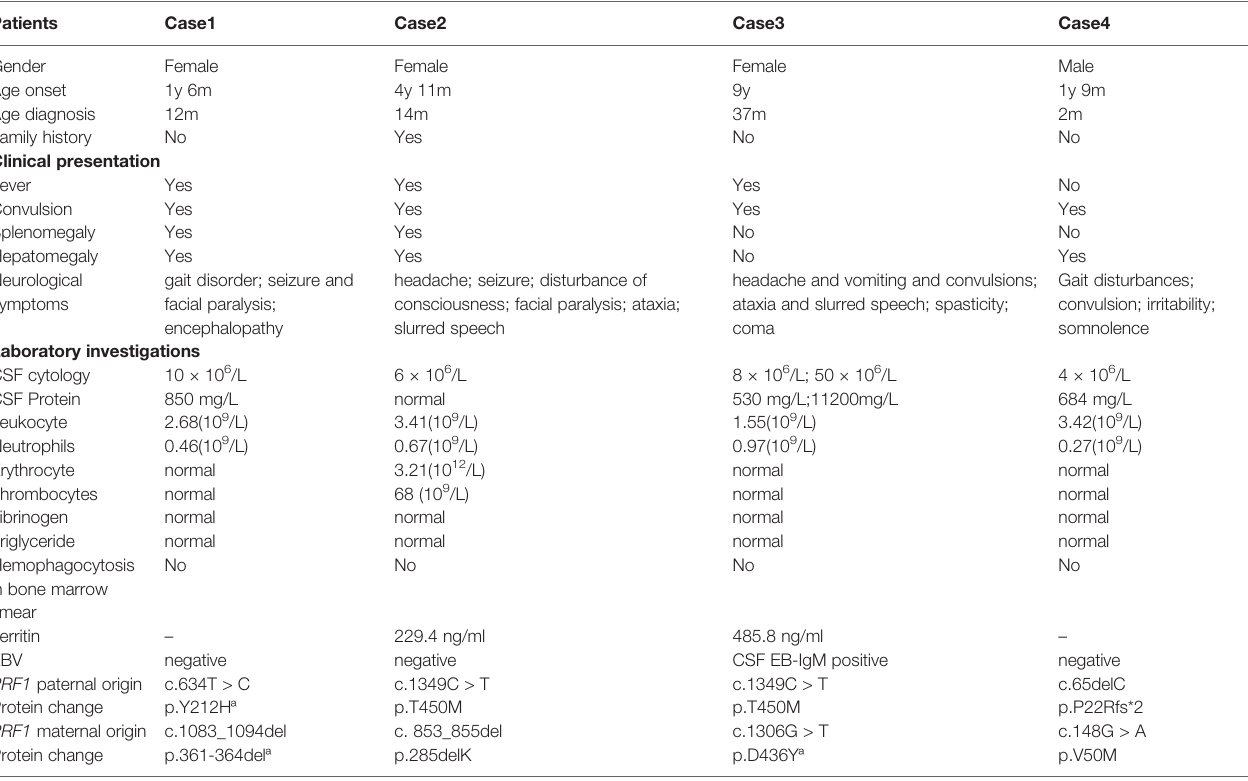
TABLE1 | Clinical Findings and Mutations of PRF1 in